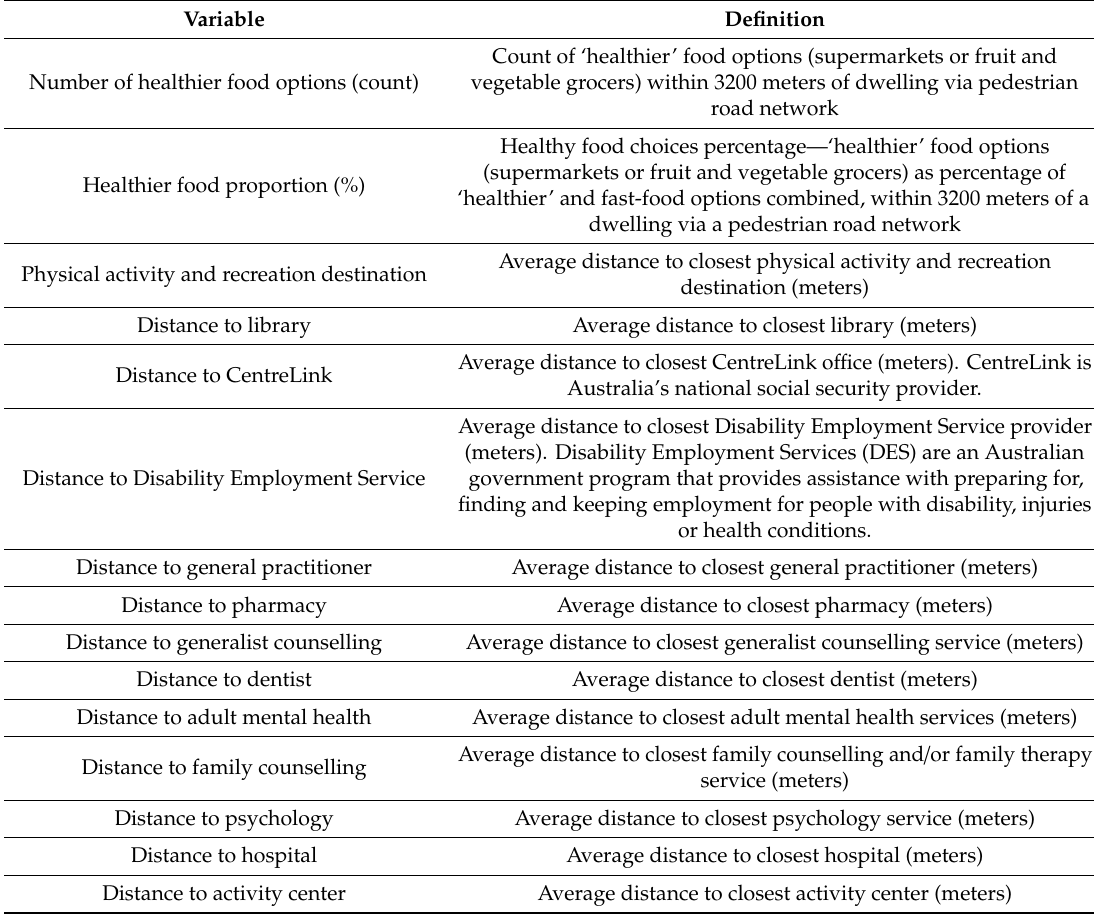
Table A1. Built environment indicators included in the